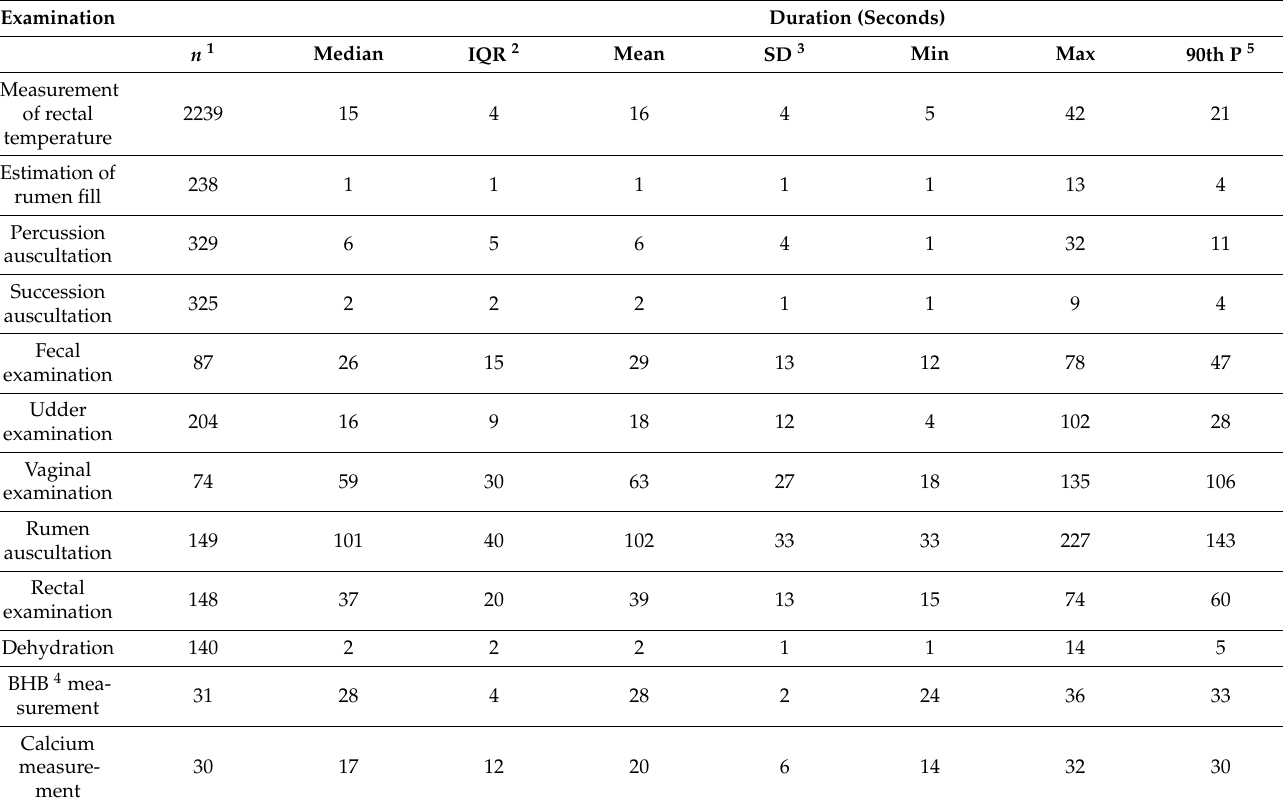
Table 4. Duration of the examinations (obtained from all three